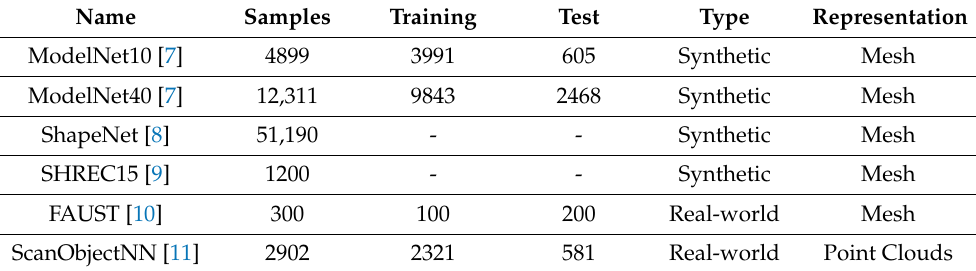
Table 1. Typical point cloud datasets for upsampling.